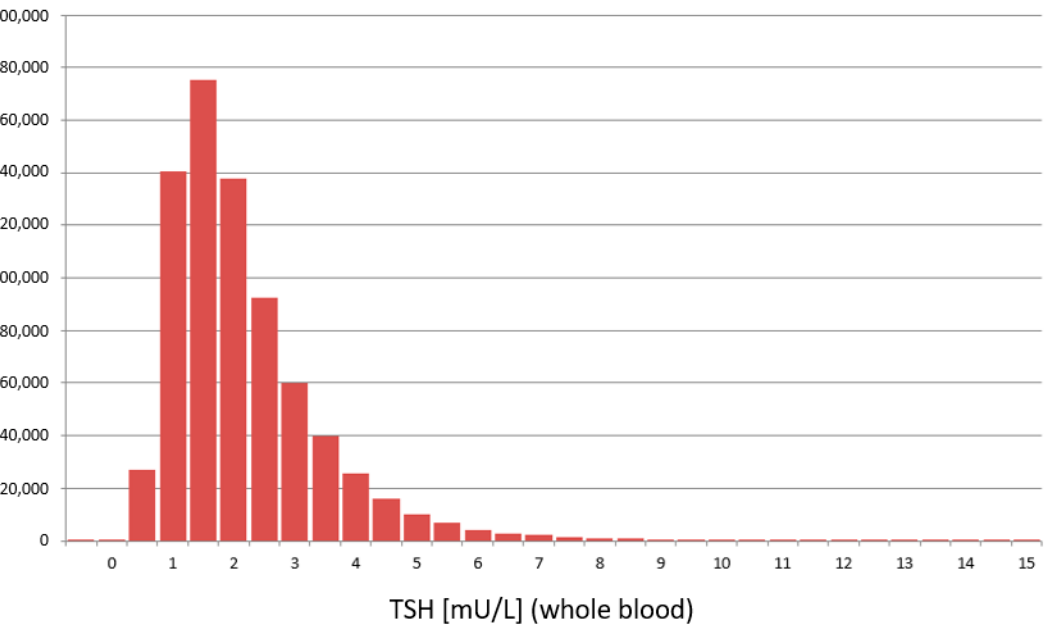
Figure 6. Distribution of TSH values measured on the LDx/NS2400 platform ( n = 116,260).